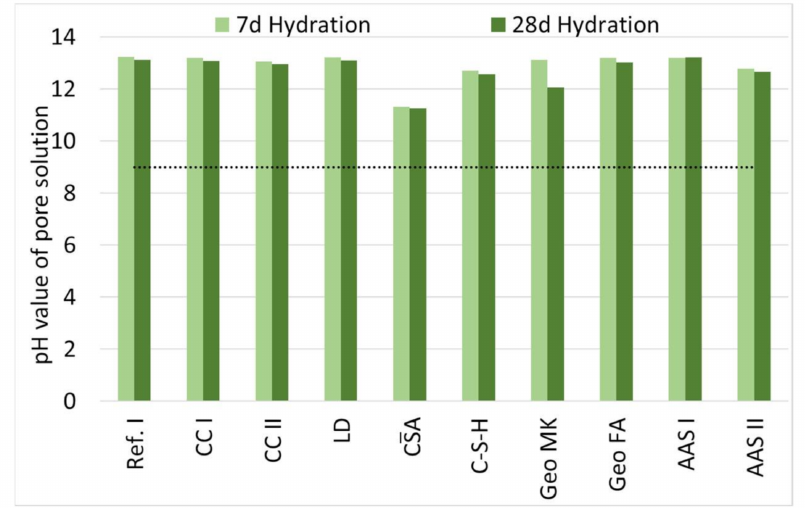
Figure 2. pH of the pore solution at age 7 d and 28 d.